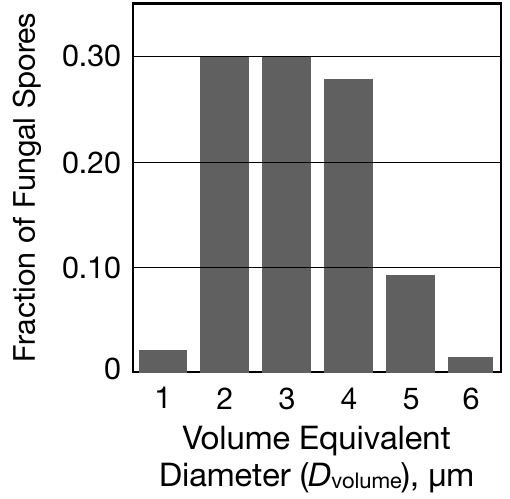
Fig. 5. Distribution of volume equivalent diameters ( D volume ) for spores of Cladosporium observed with the Olympus IX70 microscope at 20 × magnification. Only spore areas for one spore unit were included in calculations of D volume . Data are centered on integer values for D volume . The mean volume equivalent diameter is 3.2±1.0 µ m (1 σ S.D.).